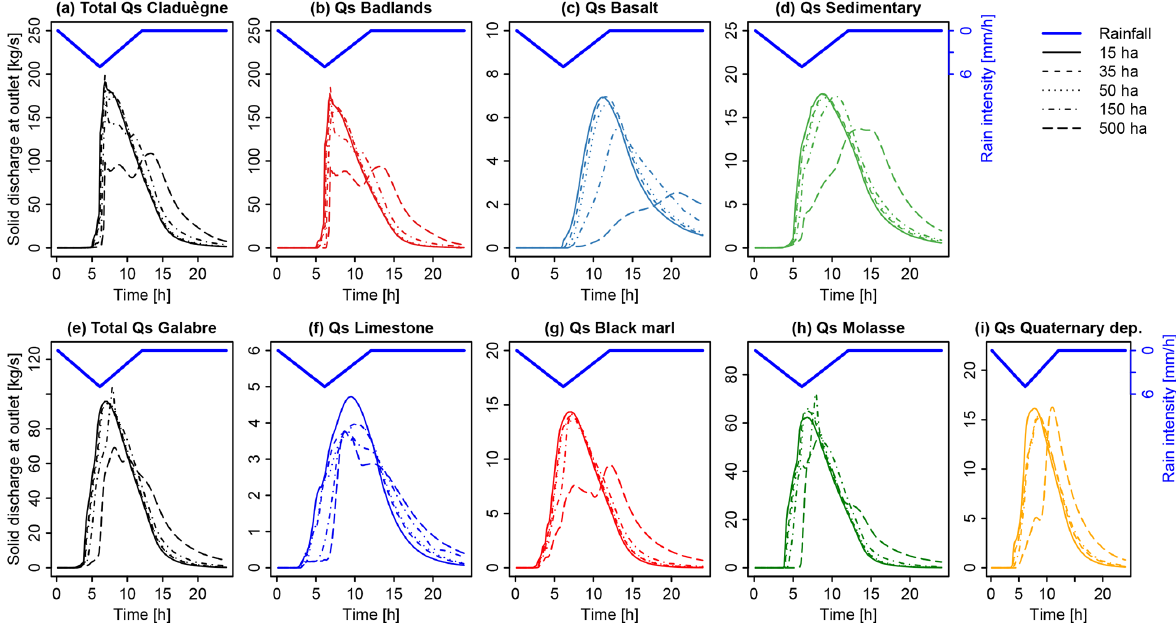
Figure 6. Simulated sedigraphs for total suspended solid discharge ( Q s ) and for each source in the two catchments when different values are used for the threshold of contributing drainage area (CDA) to define the river network.